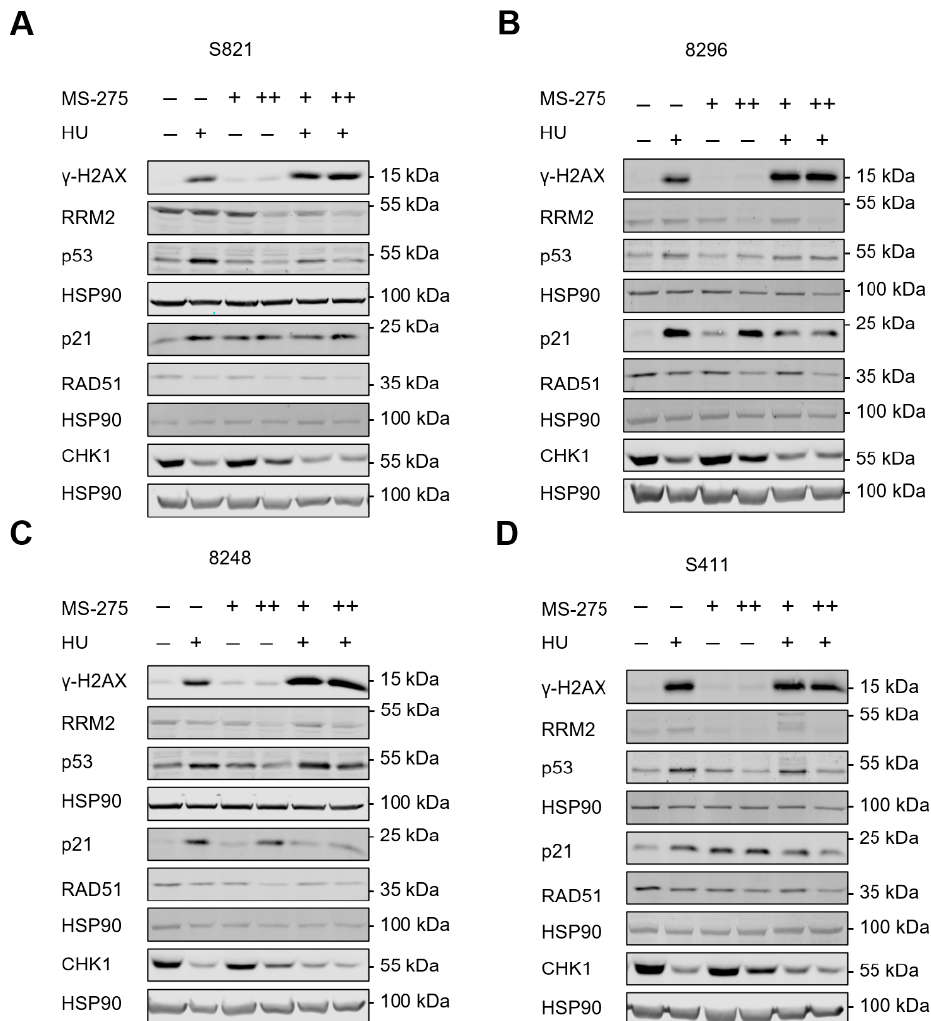
Figure 3. Immunoblot shows alterations in protein expression and posttranslational modifications in response to hydroxyurea and entinostat. ( A – D ) Mouse PDAC cell lines (S821, 8248, 8296, S411) were treated with 1 µM entinostat (+; MS-275), 5 µM entinostat (++; MS-275) and/or 1 mM hydroxyurea (+; HU) for 24 h. Immunoblot was done for the indicated proteins and HSP90 as loading control; n = 2.